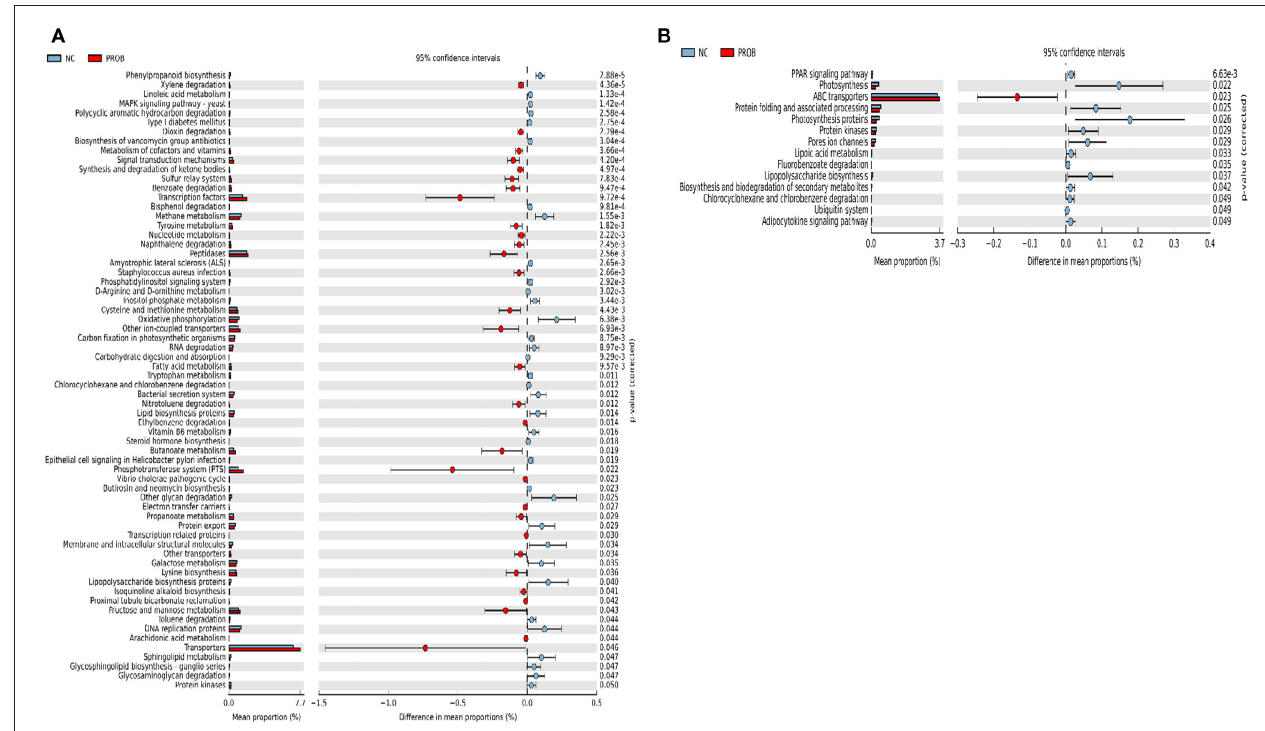
FIGURE 7 | Predicted functions of ileal mucosa microbiota in broiler chickens challenged with a subclinical naturally occurring necrotic enteritis at KEGG levels 3 ( n = 8/treatment). (A,B) Differentially regulated metabolic pathways in NC vs. PROB group on d 8 and d 42, respectively. NC (negative control): corn-soybean meal basal diet; PROB (Probiotic): NC + 227g B. licheniformis spores/ton